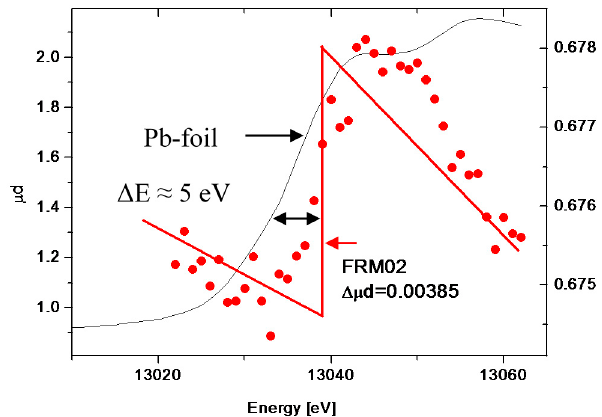
Figure 3. XANES spectrum of FRM02 measured at the Pb L III -edge at 13,035 eV. The solid (black) line represents the XANES spectrum of a Pb-metal foil ( y -axis on the left). The FRM02 spectrum reveals a chemical shift of about 5 eV. Δμ d is the difference of the absorption coefficient times the sample thickness and represents the Pb-L III -edge of the sample taken from the y -axis on the right.